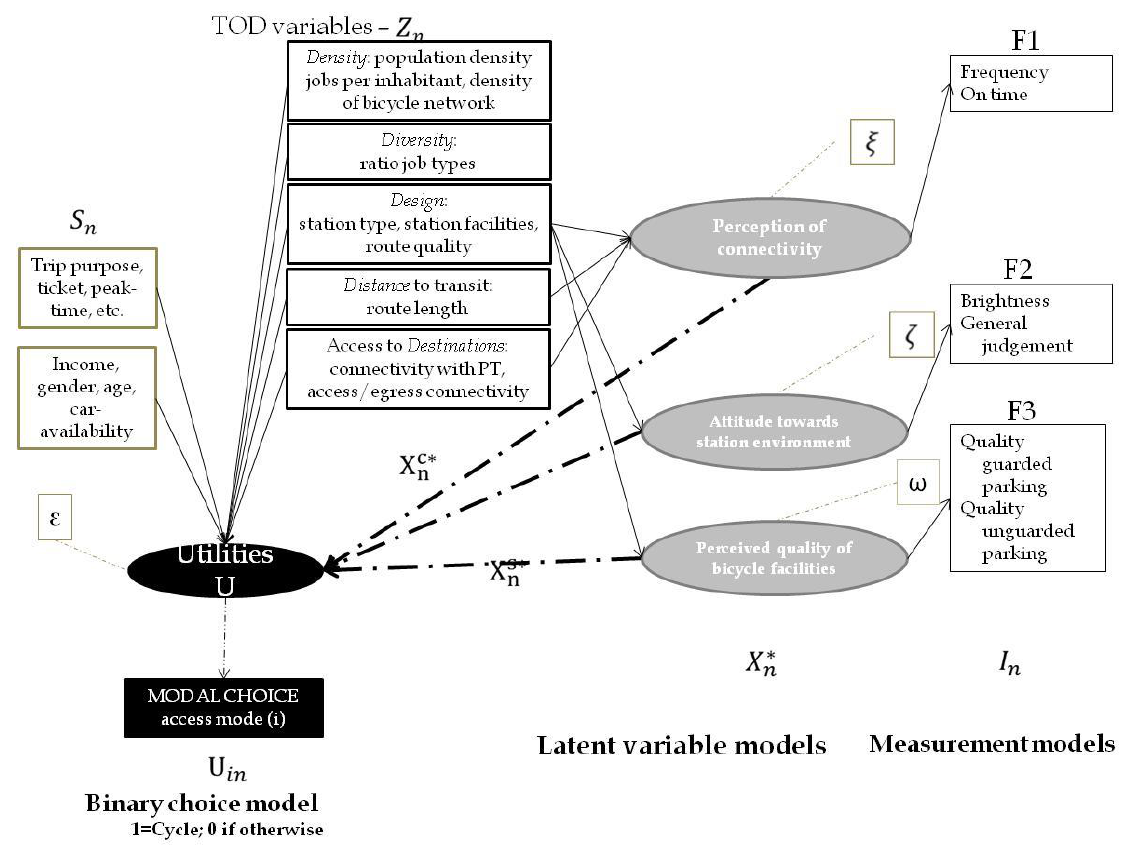
Figure 3. General framework of the hybrid choice